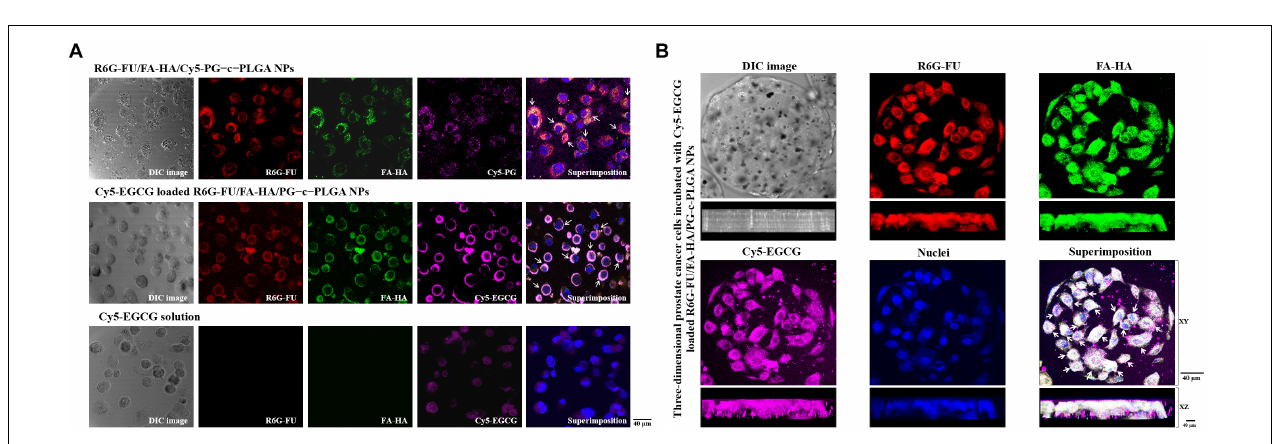
FIGURE 4 | (A) Confocal images of prostate cancer cells showing cellular distribution of the NP preparations. (A) Treatment with only R6G-FU/FA-HA/Cy5-PG–c–PLGA NPs or Cy5-epigallocatechin gallate (EGCG)-loaded R6G-FU/FA-HA/PG–c–PLGA NPs vs. Cy5-EGCG. (B) Three-dimensional analysis of fluorescent PC3 cells adhered to Matrigel-coated microcarriers incubated with fluorescent Cy5-EGCG-loaded R6G-FU/FA-HA/PG–c–PLGA NPs.